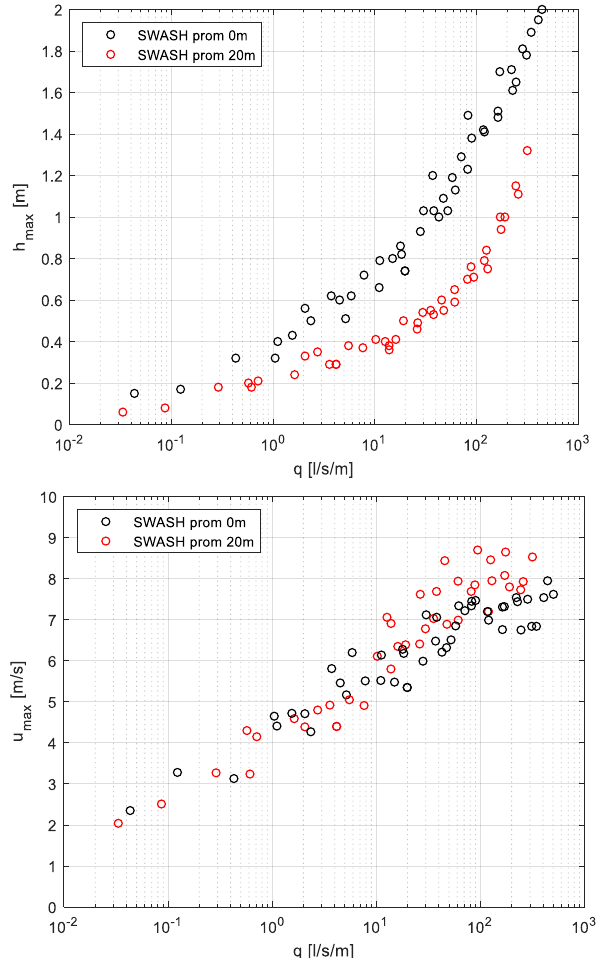
Figure 5. Comparison between promenade width 0 m and 20 m on q-h max ( upper figure ) and q-u max ( lower figure ).